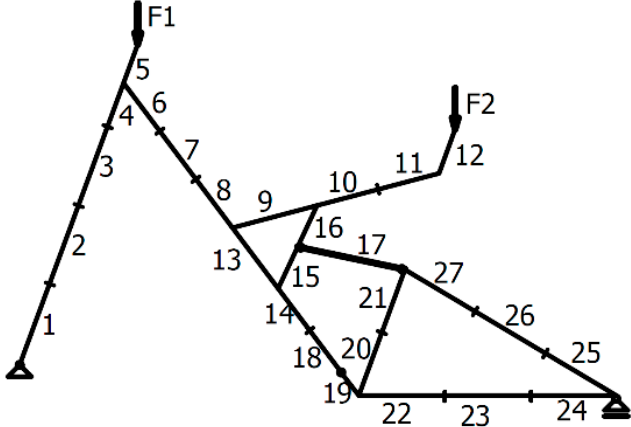
Figure 10. Finite element model of bicycle frame (reprinted from [23], with the permission of AIP